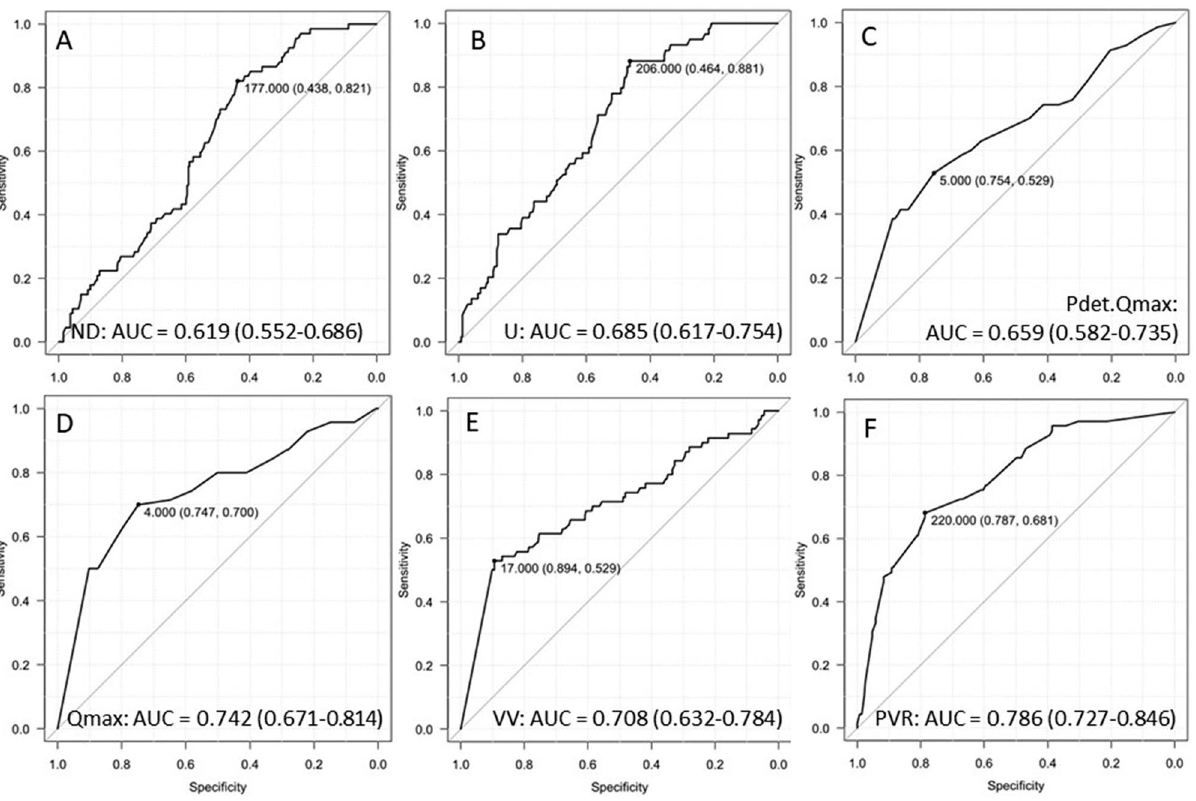
Figure 2. ROC curves for predicting factors for BOO: (A) normal desire, (B) urgency, (C) Pdet.Qmax, (D) Qmax, (E) voided volume, (F)